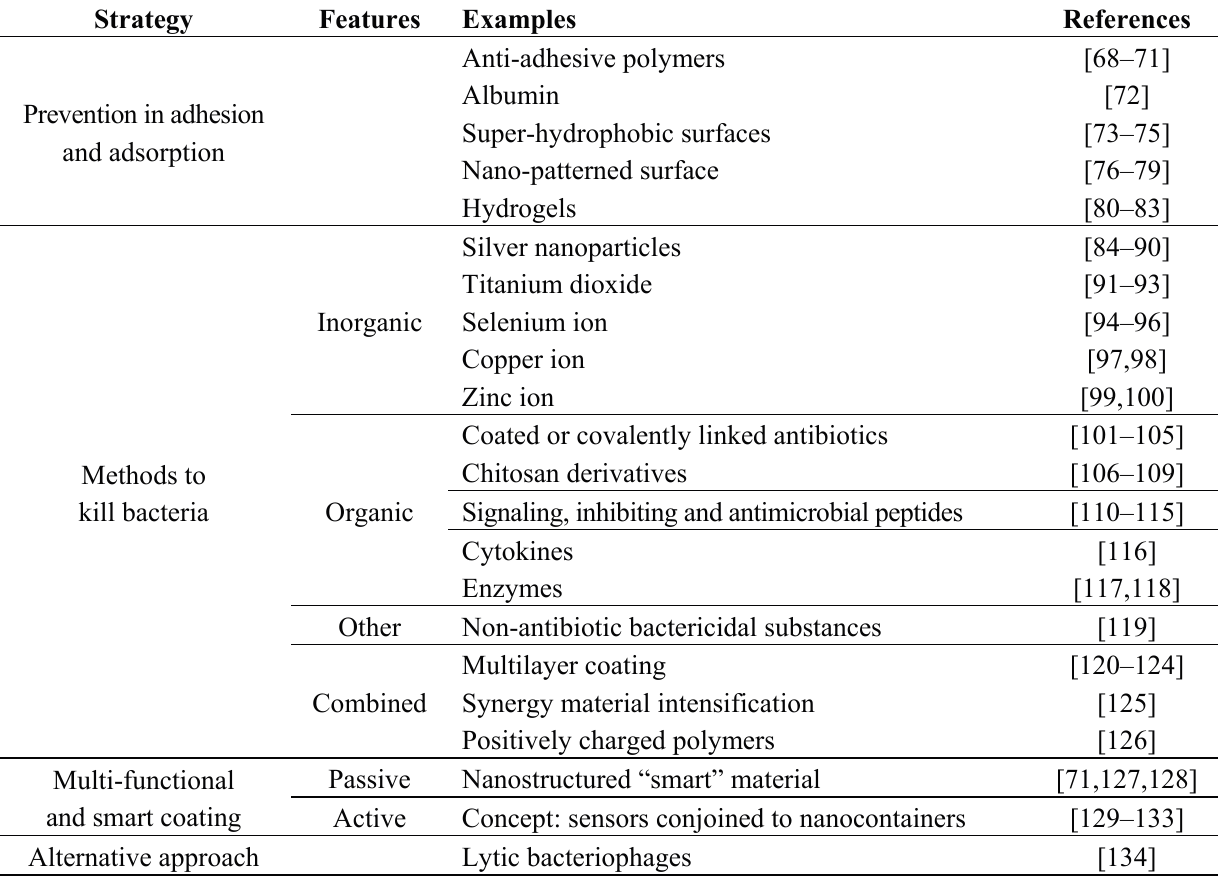
Table 1. Examples of anti-infective strategies proposed for treating of surfaces used in orthopaedic